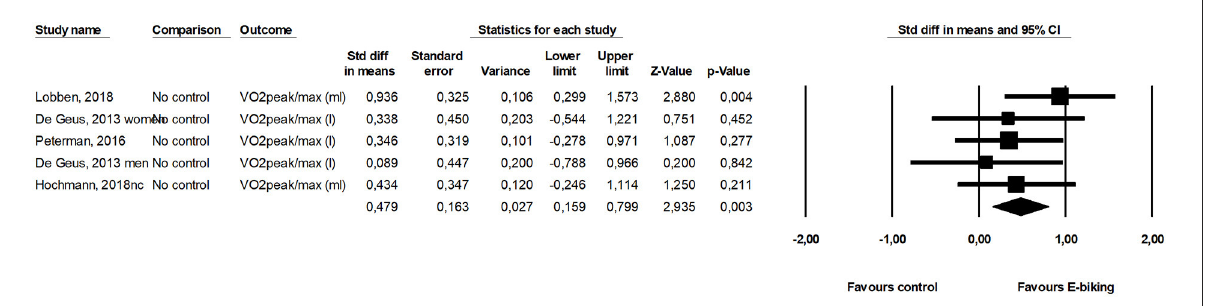
FIGURE2 Forest plot for the effect of E-cycling on maximal oxygen consumption.